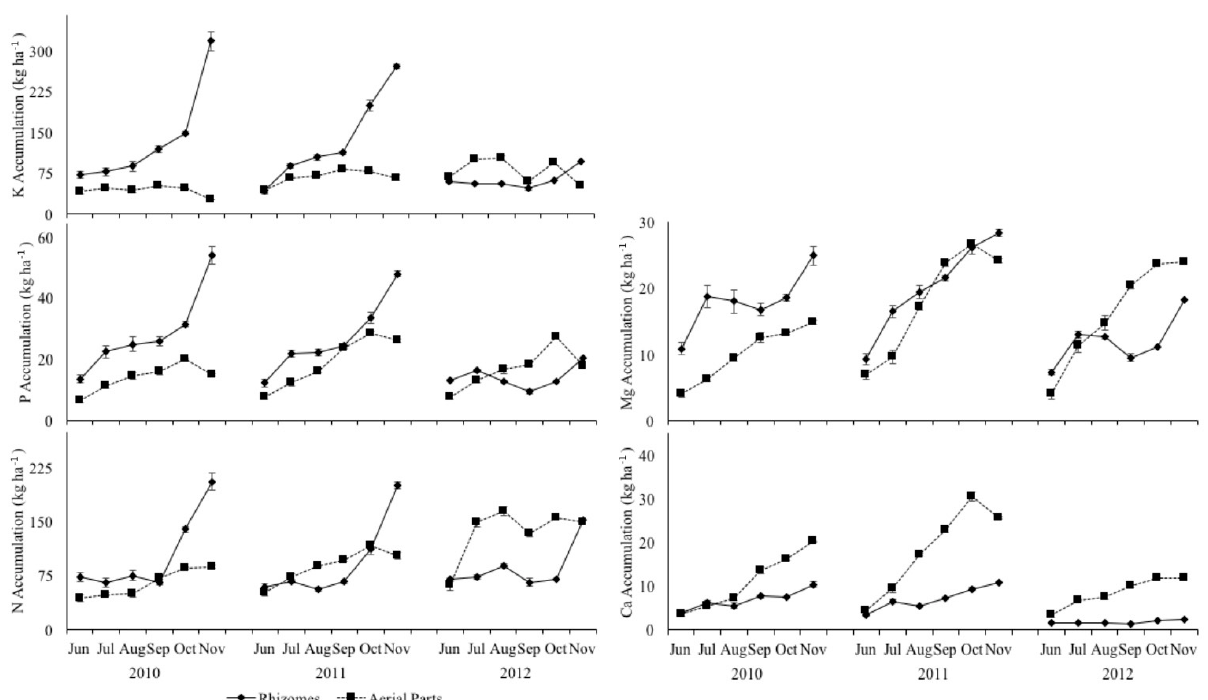
Figure 5. Macronutrients (N, P, K, Ca and Mg) accumulation by rhizomes and aerial parts in years 2010–2012. There was a large increase in the later months (October and November) of N, P and K content of rhizome. This increase was associated with an increase in the ratio of N, P and K in the rhizome compared with aerial biomass (Figure 6) but not a large decrease in absolute concentrations within aerial biomass (Figure 5). The trend was different in 2012; for example, N concentrations in the stems and leaves reached levels significantly higher ( p > 0.01) than previous years. Despite the significantly higher level of N in above ground organs in 2012, the amount in the rhizomes did not decrease further than in 2010 and 2011, suggesting there was more N within the plant system. The ratio of nutrients in rhizome: aerial biomass showed a gradual decline across the three growing seasons (Figure 6) re- flecting less nutrient in the rhizome and/or more contained in above ground biomass. In 2012, the Ca content of rhizome and aerial biomass was significantly ( p > 0.01) lower than in 2010 and 2011; however, Ca amounts were very different in both the rhi- zome and aerial biomass across the three studied years. Unlike N, P and K, Ca content was consistently higher in above ground biomass than in rhizome. For most months across the three-year study period, Ca in the above ground organs generally increased simultaneously with rhizome concentrations. There were some minor exceptions to this, such as November 2011, and the increase was less prominent in 2012. Magnesium amounts followed a similar trend to that of Ca; as accumulations in the rhizome increased, the above ground concentrations increased; however, the trends were less consistent throughout the season. In 2012, Mg levels in the rhizomes were significantly lower ( p > 0.01) than in 2010 and 2011. Mg amounts in above ground biomass were significantly ( p >